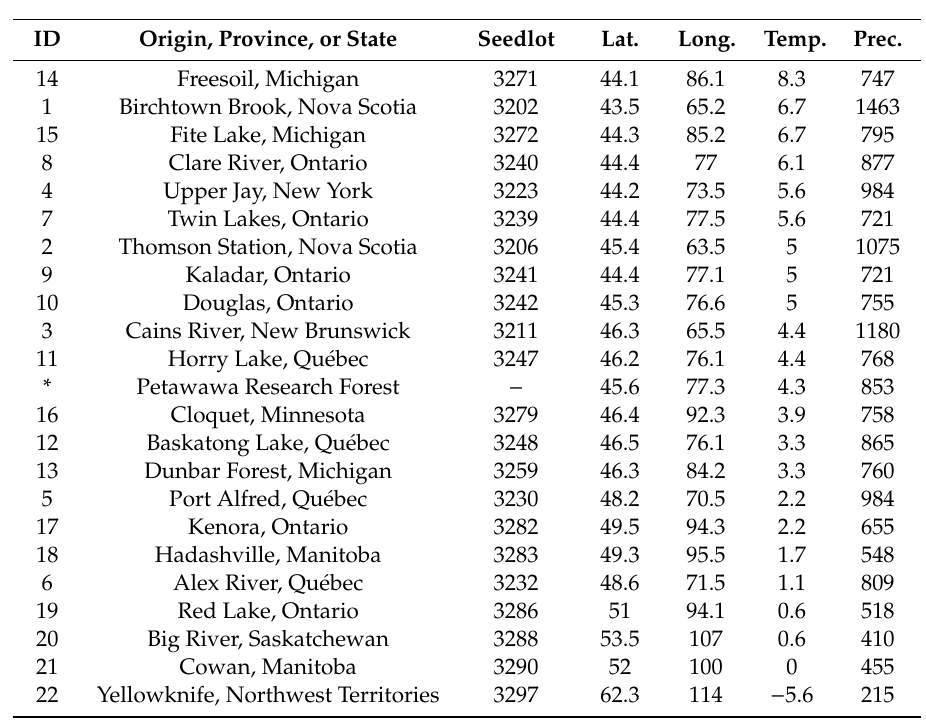
Figure 1. Map of the geographical locations of the provenances and the plantation site. The star indicates the provenance trial location. Table 1. Geographic and climatic description of the provenances (ranked in descending order of mean annual temperature) and the plantation site (*, Petawawa Research Forest).